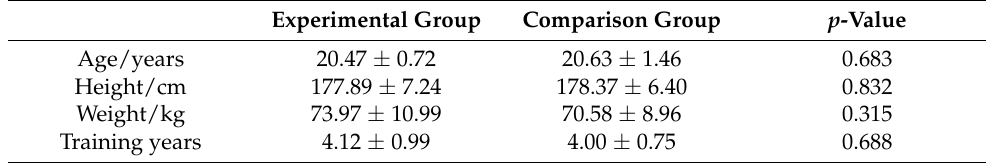
Table 1. Basic information of